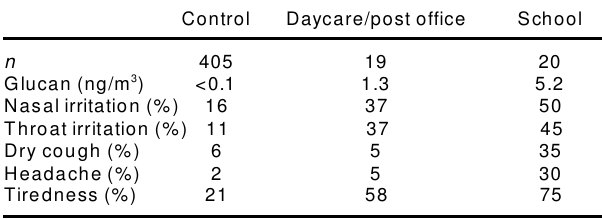
Table 2. Airborne levels of (1 ® 3)- b - D -glucan in relation to extent of symptoms (percentage of subjects expressing symptoms)